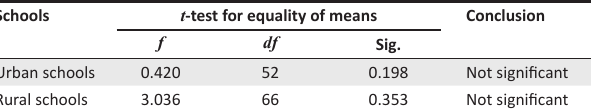
TABLE 9: Results of t -test for the N -gain score of student disaster